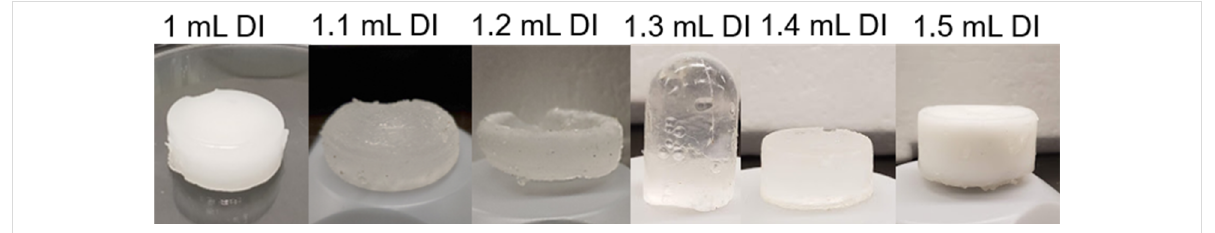
Figure 1: Images of pHEMA gels prepared with different quantities of DI